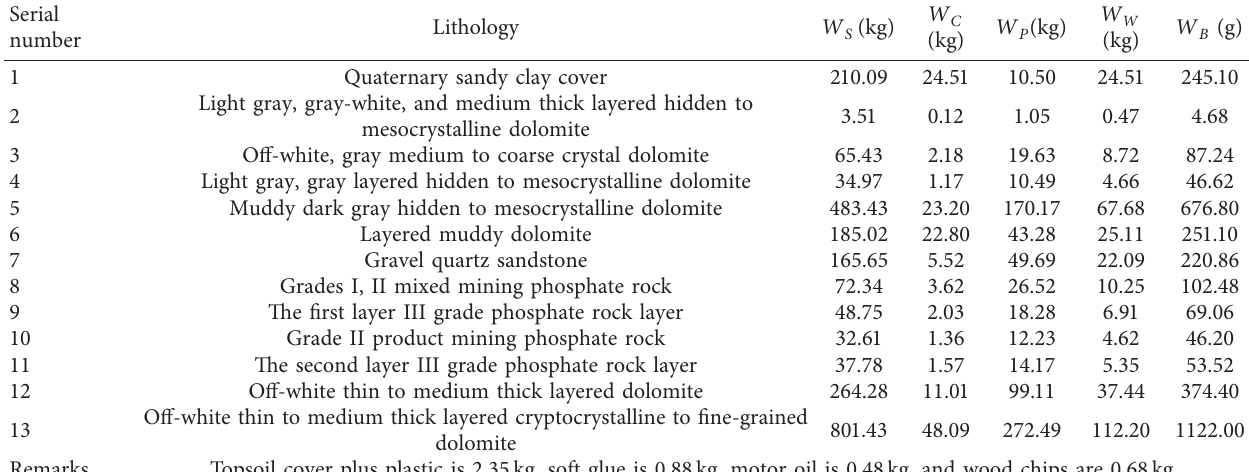
Table 2: Material consumption of model five-nine exploration line of the north mining area of the second pithead of Jinning Phosphate